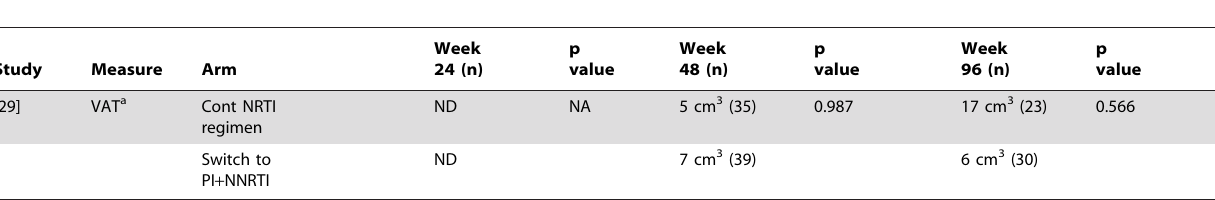
Table 22. Switching studies: change from baseline in visceral adipose tissue (VAT) on CT scan: NRTI-containing versus NRTI- sparing regimens.